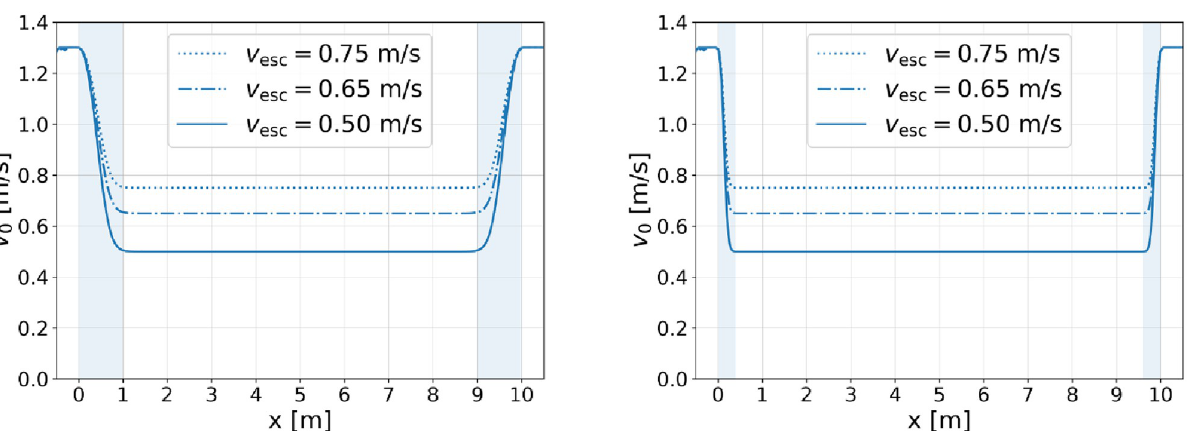
Fig 3. Speed of a single agent, depending on the position on the escalator. Shown are simulation results obtained for c = 50 (left) and c = 500 (right), and for the common escalator speeds v esc 2 {0.50, 0.65, 0.75} ms − 1 , respectively. The desired speed of free walking on the plain is here v 0,horiz. = 1.3 ms − 1 . The shaded areas indicate regions where the agent speed is adapting to the one of the respective escalator. The corresponding adaptation lengths are approximately 1.0 m (left panel) and 0.4 m (right panel).